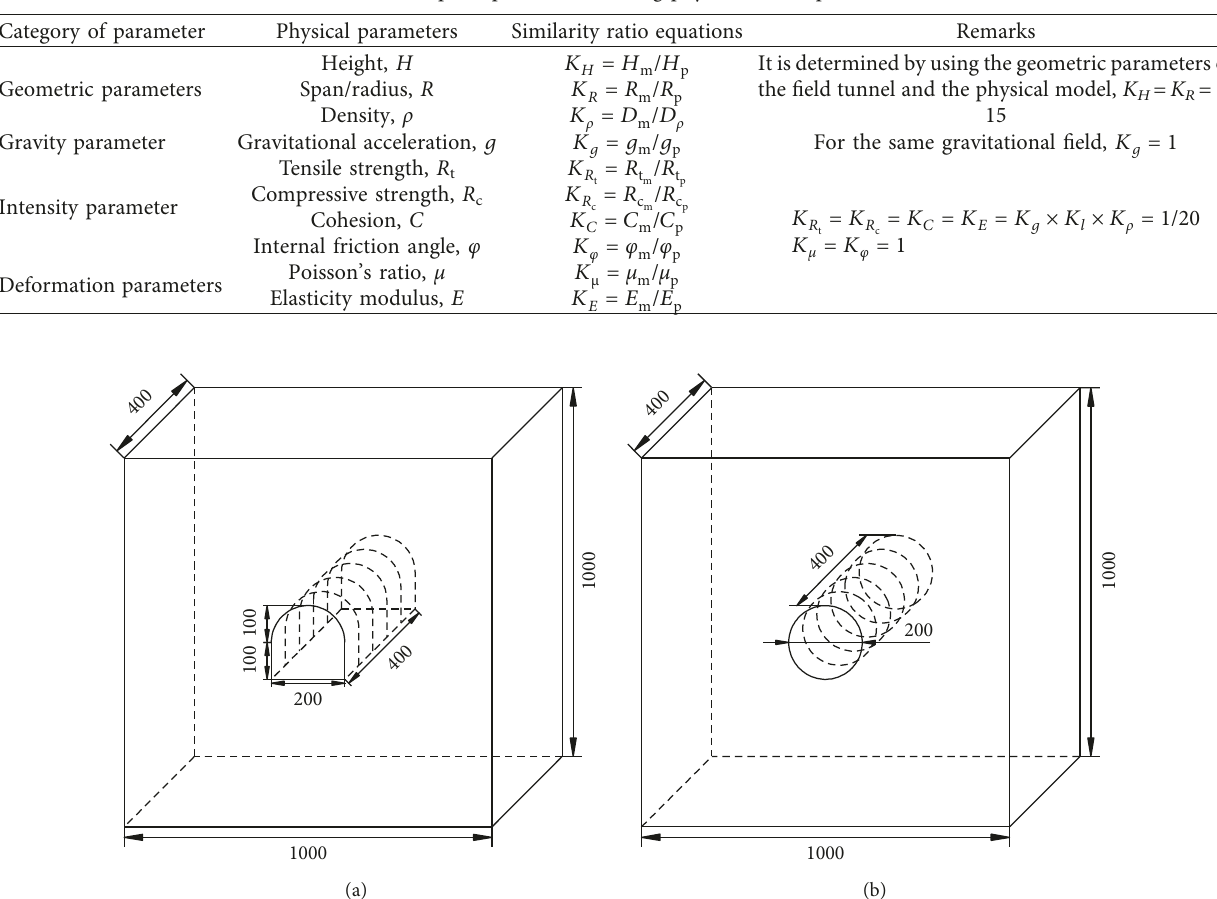
Figure 4: Model used in physical model tests. (a) Horseshoe tunnel. (b) Circular tunnel.